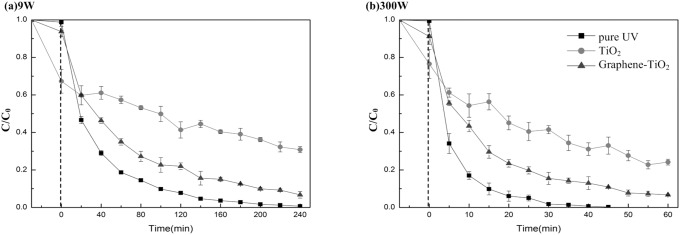
Photocatalytic degradation of PCP with TiO2, graphene-TiO2 and without catalyst under: (a) 9 W UV light; (b) 300 W UV light.